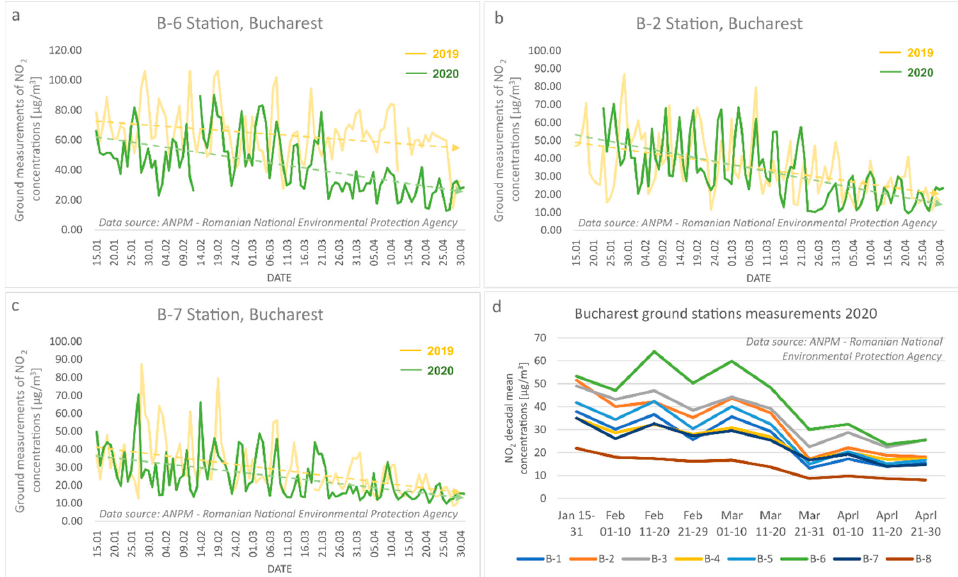
Figure 15. NO 2 concentrations dynamics between 15 January and 30 April in 2019 and 2020 measured at different ground stations in Bucharest, classified as urban traffic ( a ), urban background ( b ), and suburban ( c ). NO 2 10-day mean concentration dynamics from 15 January to 30 April 2020 at all air quality monitoring ground-based stations in Bucharest ( d ).